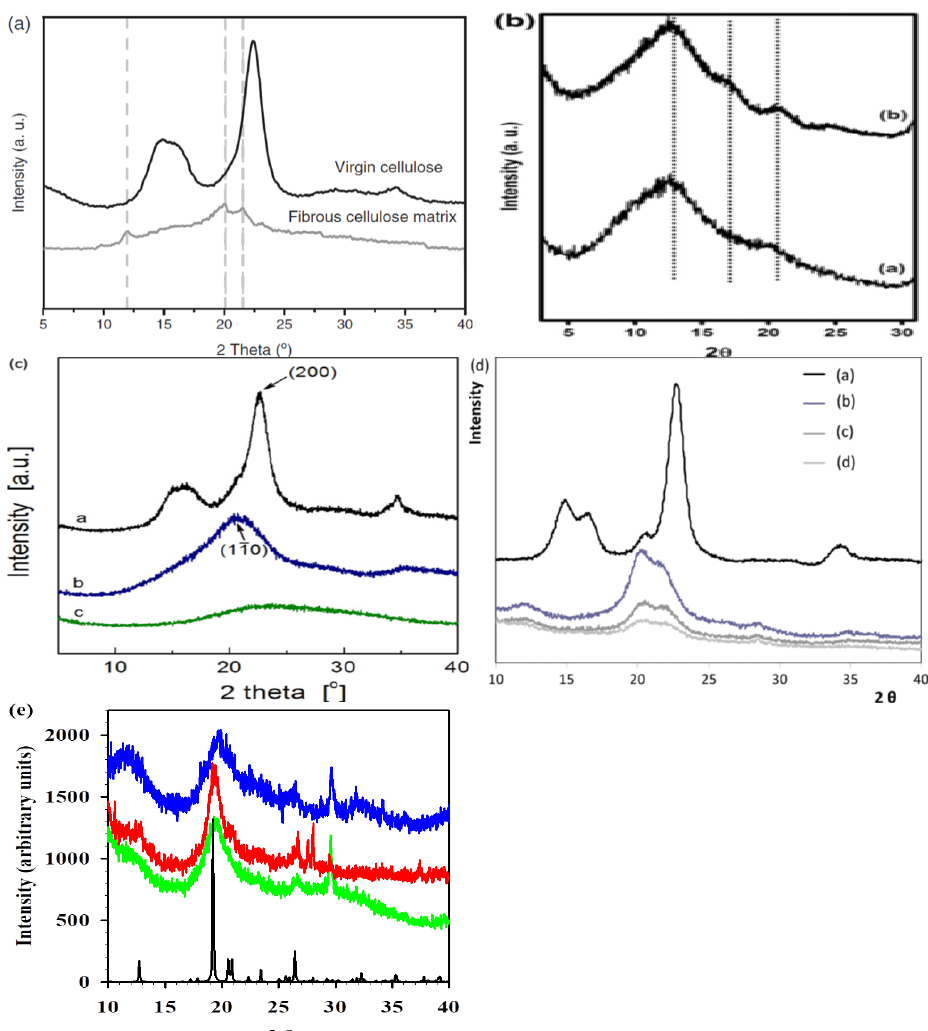
Figure 6. XRD patterns of ( a ) electrospun cellulose fibers ( bottom ) [6]; ( b ) electrospun silk fibers ( top ) [36]; ( c ) electrospun cellulose fibers ( bottom ) [14]; ( d ) electrospun cellulose fibers (middle c) [7]; and ( e ) electrospun chitin fibers ( top ) [1] assisted by different ionic liquids as solvents.